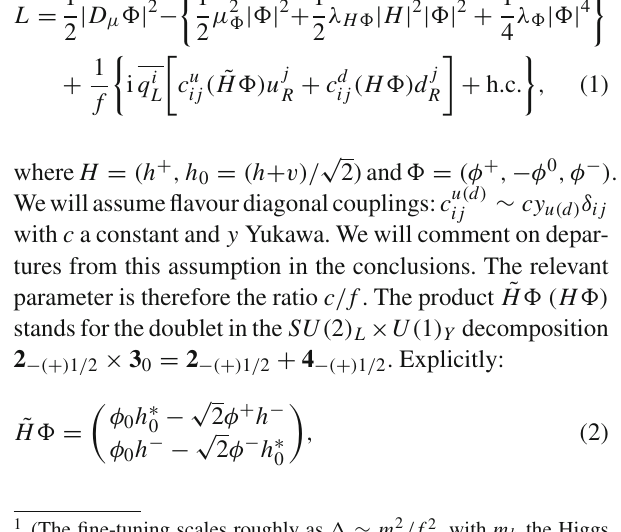
Fig. 1 Exoticdecaywidthsofthedifferentheavyparticlesinourmodel for f = 1